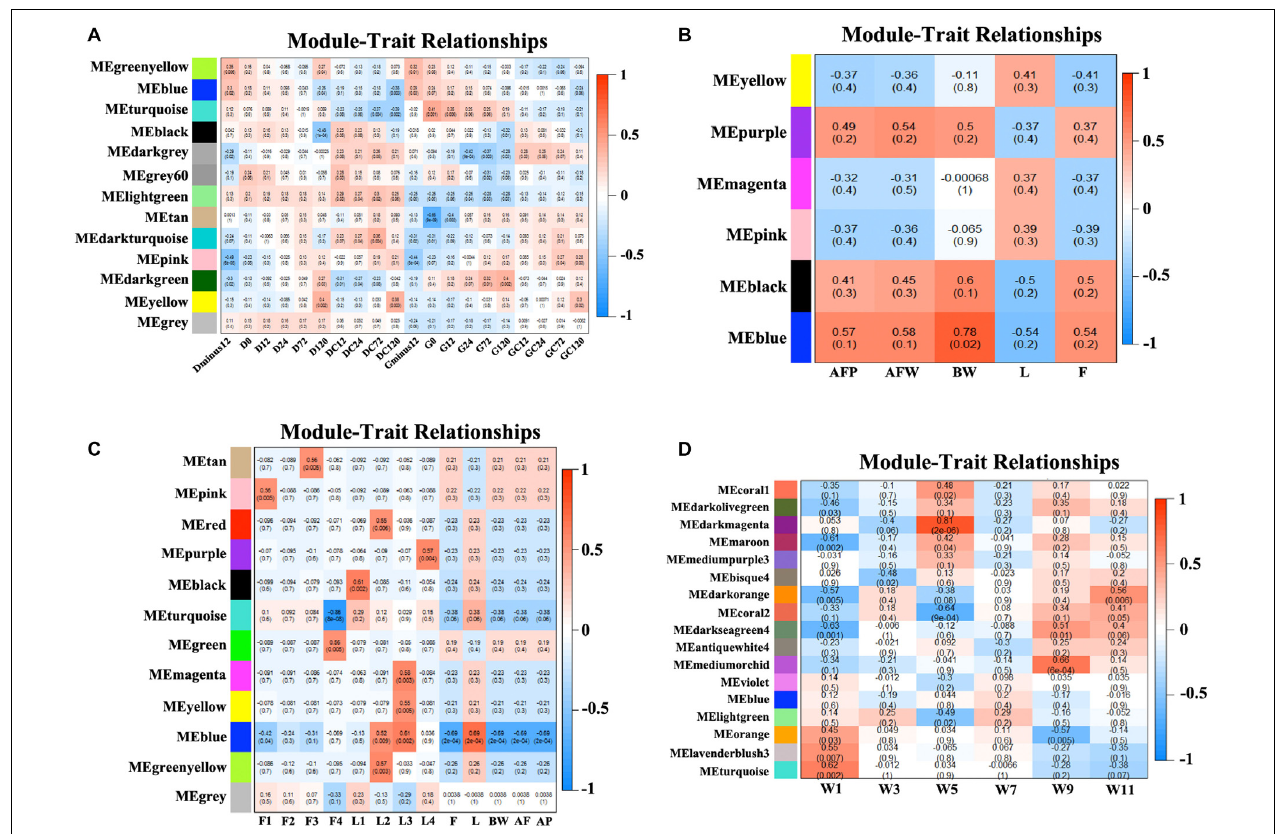
FIGURE 2 | Module-trait heatmaps. Gene modules and trait relationships established by correlation analyses. (A) NEAUHLF: preadipocyte microarray. (B) NEAUHLF: adipose tissue microarray. (C) French: adipose tissue RNA-seq. (D) French: adipose tissue microarray.